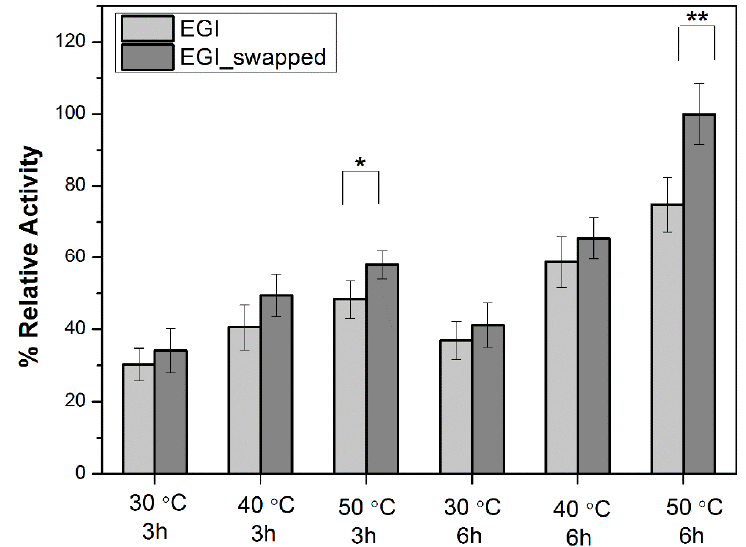
Figure 2. The enzyme activity profiles of EGI and EGI_swapped enzymes toward CMC for 3 h and 6 h at 30–50 ◦ C (/10 ◦ C). Data are express as mean ± SD, n = 3. p -values between 0.1 and 0.05, and p -value smaller than 0.05 are indicated with ‘*’ and ‘**’ on plots,